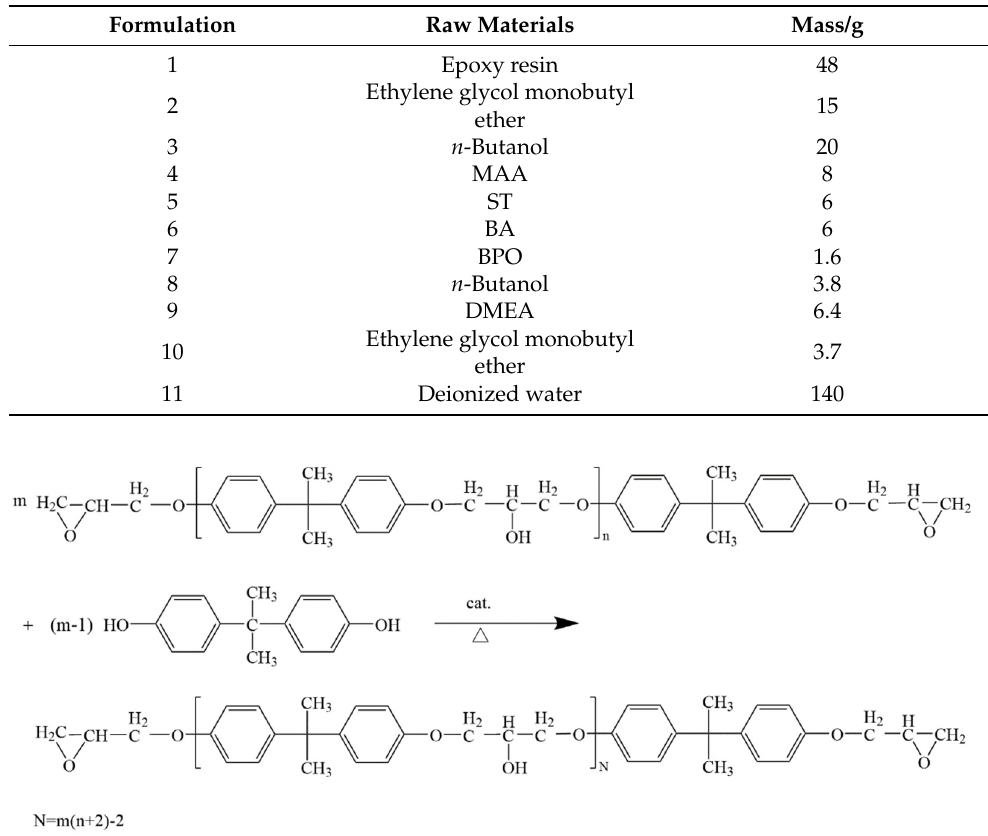
Table 1. Formulations for the preparation of emulsions.